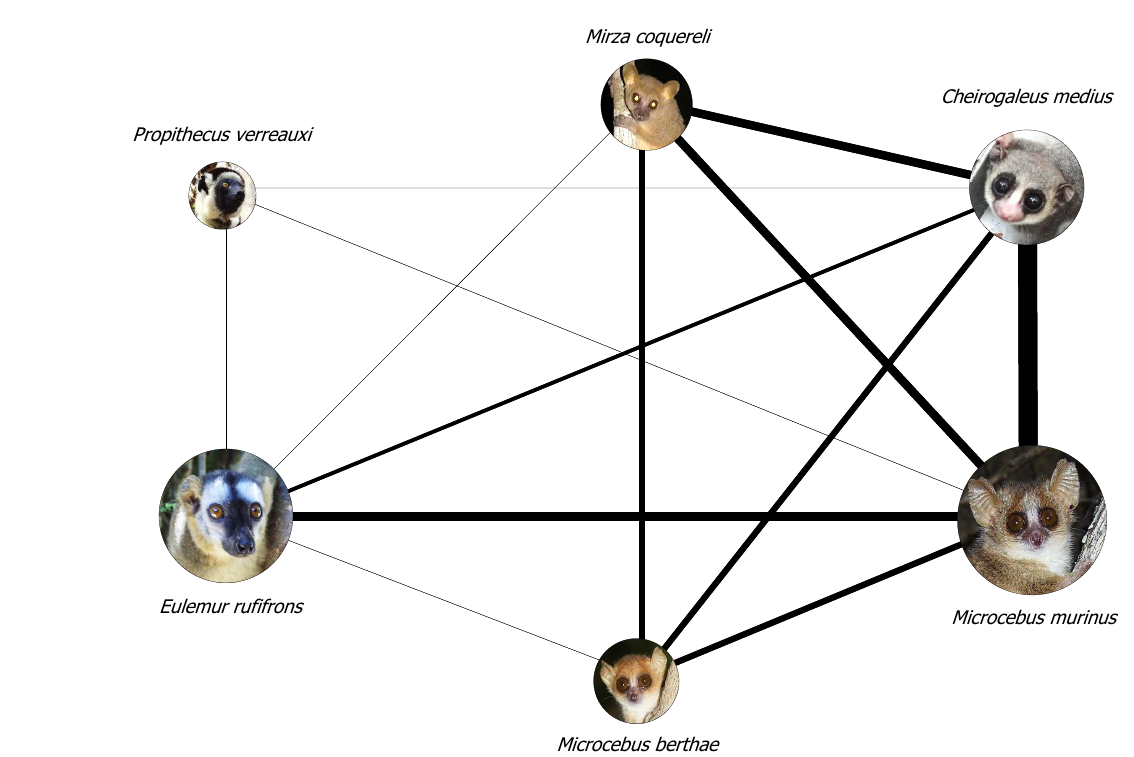
Figure 1. Parasite morphotype sharing network of six sympatric lemur species at Kirindy Forest, Madagascar. Node size corresponds to the number of parasite morphotypes detected in a species, while line width reflects the number of shared morphotypes.